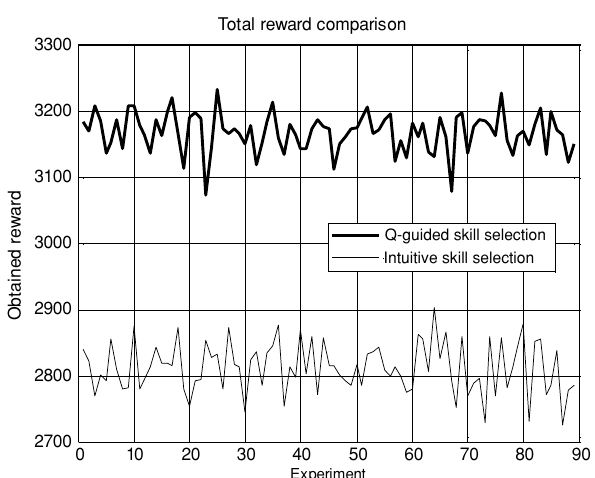
Figure 6 Q -learning (solid line) versus intuitive algorithm (dashed line) rewards. The policy found by Q -learning offers better results than using an intutive algorithm.